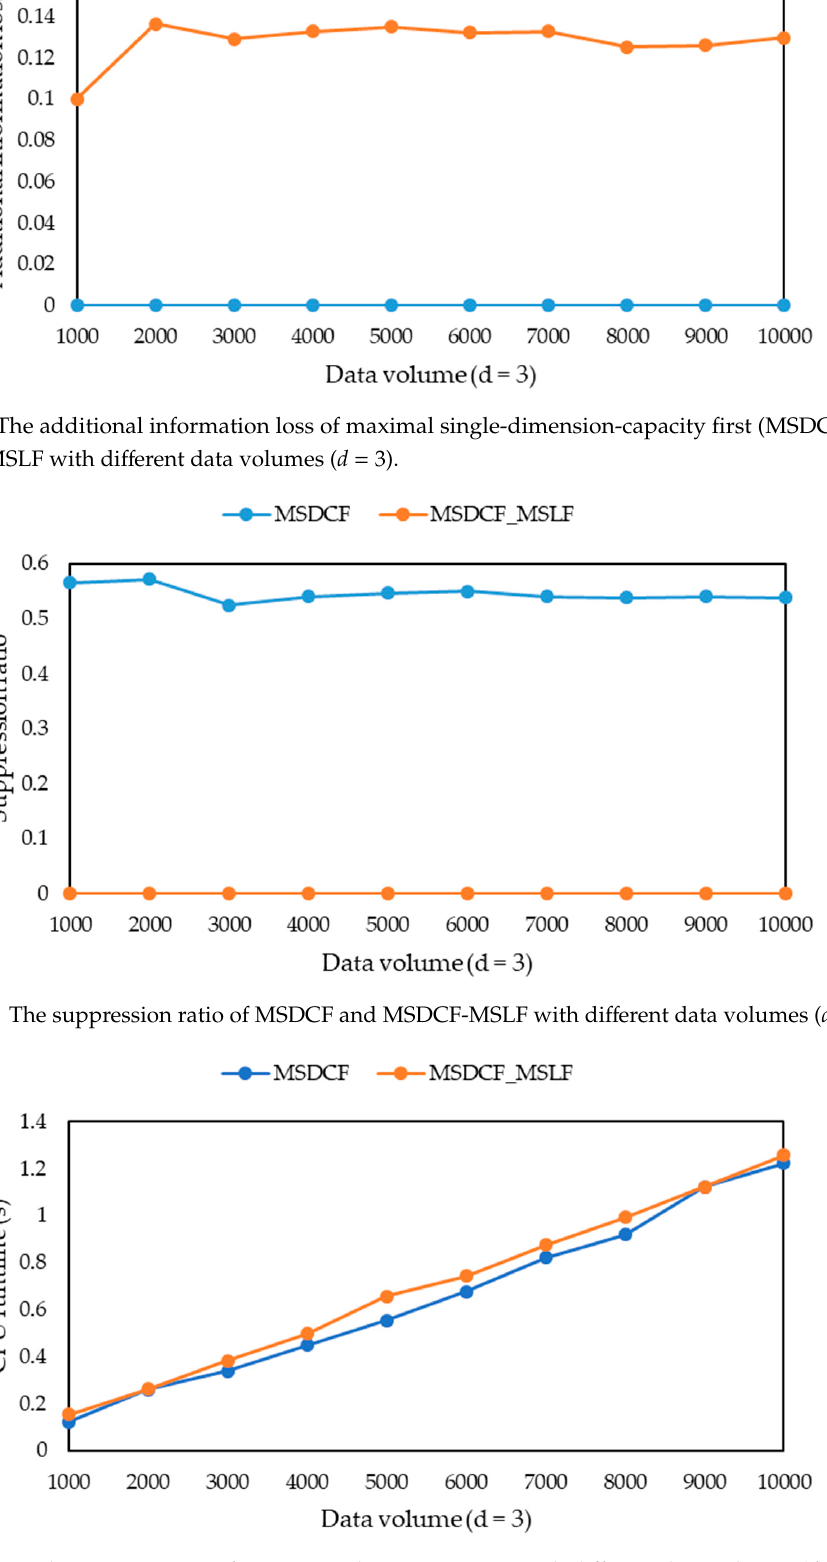
Figure 10. The CPU runtime of MSDCF and MSDCF-MSLF with different data volumes ( d = 3).